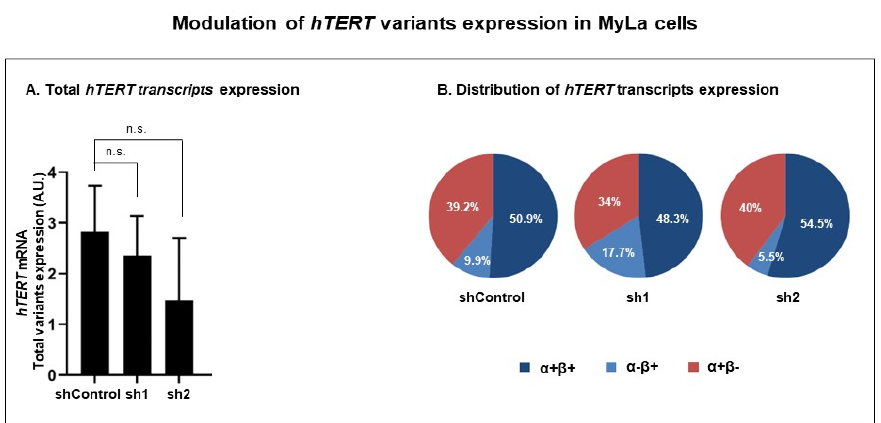
Figure 4. Modulation of hTERT variants expression in MyLa cells. MyLa cells were transduced with shRNAs (sh1 and sh2) targeting hTERT β variants, and with a non-targeting shRNA (sh control). ( A ) hTERT transcripts expression. ( B ) Distribution of hTERT transcripts expression. β + variants are presented in blue and β − variants in red. A.U.: arbitrary unit; shRNAs: short hairpin RNAs; hTERT: human telomerase reverse transcriptase.